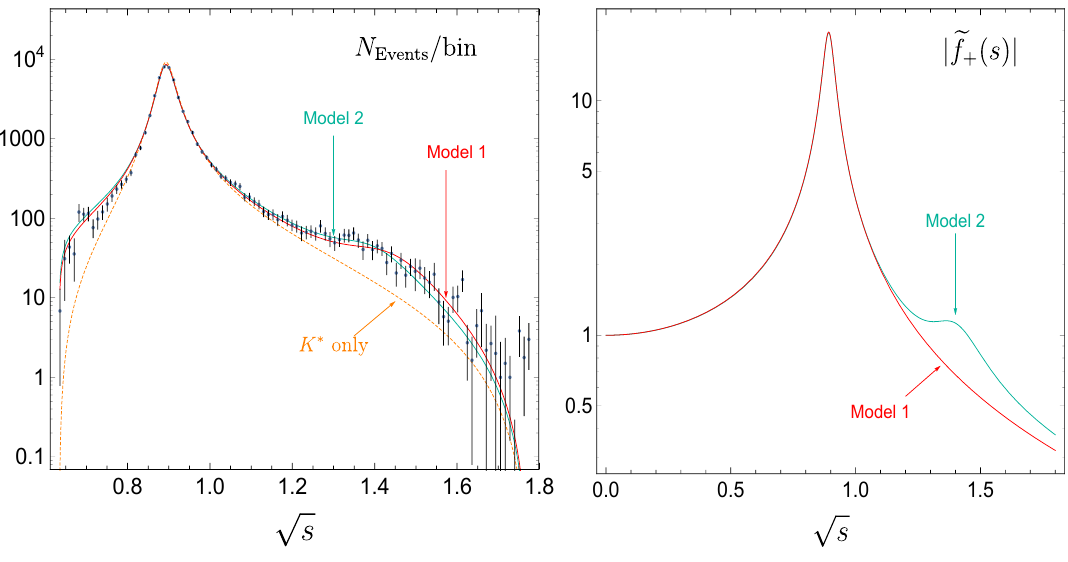
Figure 1 . Left: (cid:28) ! K S (cid:25) (cid:0) (cid:23) (cid:28) spectrum from Belle [36], and the corresponding curves from Model 1 and Model 2 (two solid lines) as well as the isolated contribution from the K (cid:3) (892) (dashed). Right: normalized form factor e f + ( s ) in the two models that (cid:12)t well the